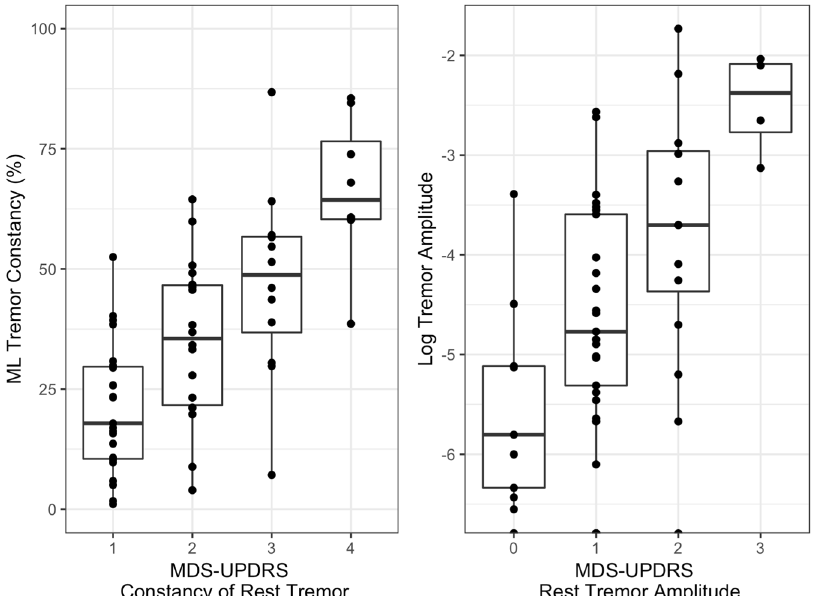
Fig. 3 Sensor-based assessments of resting tremor and clinical ratings. Agreement between a sensor-derived measures of resting tremor constancy and MDS-UPDRS score of rest tremor constancy, and b sensor-derived measures of resting tremor amplitude and MDS-UPDRS score of rest tremor amplitude. Box plot center line, median; box limits, upper and lower quartiles; whiskers, 1.5× interquartile range; points,